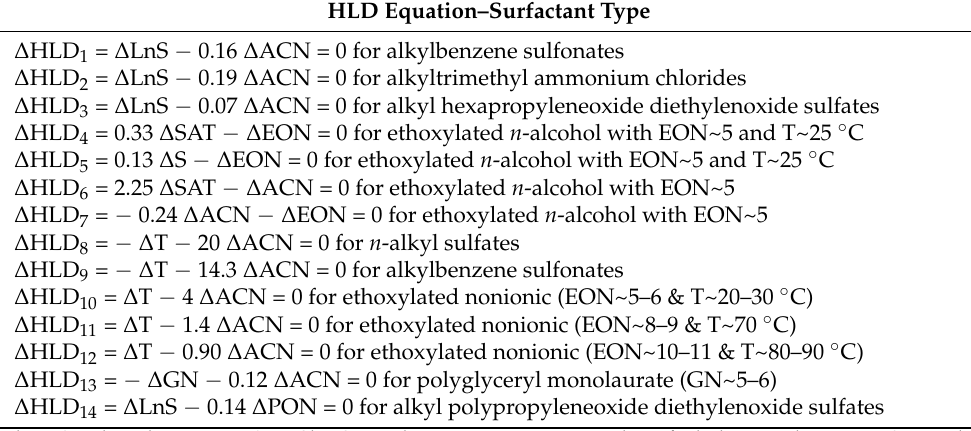
Table 2. Different cases of equations indicating the changes of two formulation variables to deviate from optimum formulation and to return to it ( ∆ HLD = 0) with coefficients found in experimental data. HLD Equation–Surfactant